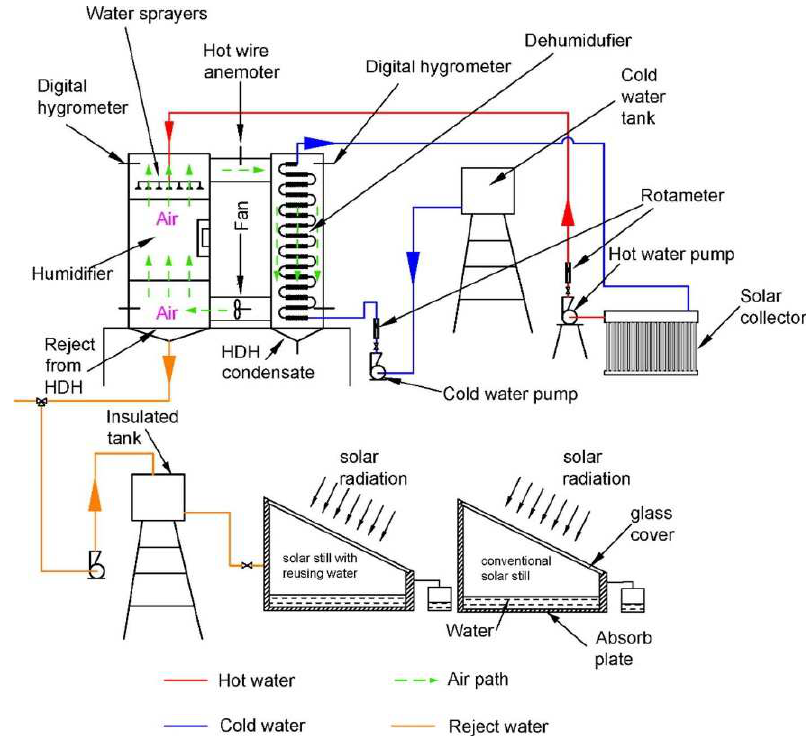
Figure 13. Diagrammatic representation of a hybrid solar HD desalination system with a single still and a traditional solar still. Reproduced with permission from S. W. Sharshir, Guilong Peng, Nuo Yang. M. O. A. El-Samadony, A. E. Kabeel, Applied Thermal Engineering Journal, published by Elsevier, 2016 [223].